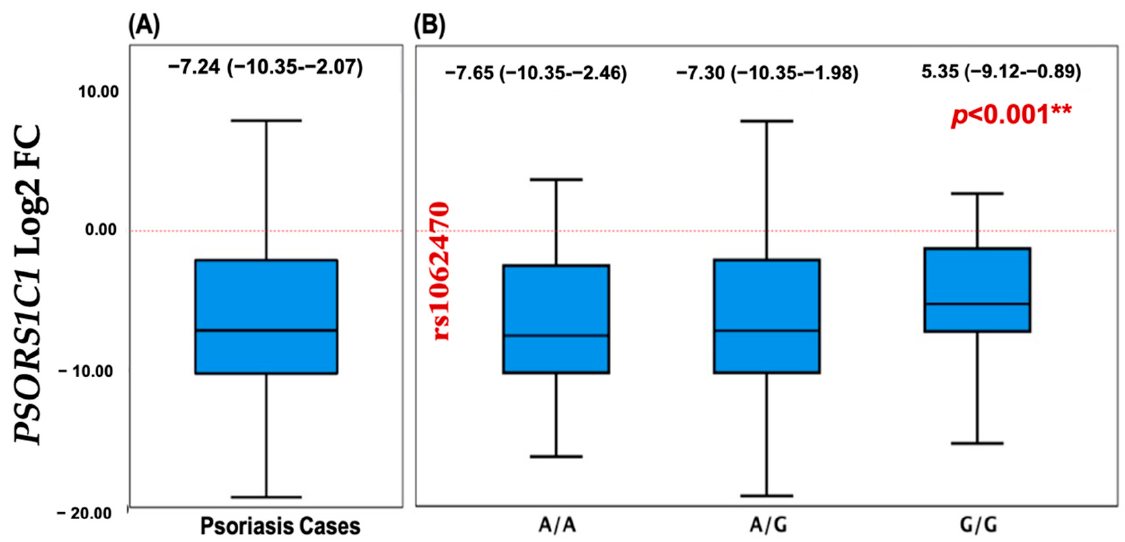
Figure 4. The relative expression profile of the PSORS1C1 gene in psoriasis plasma samples. Data are shown as medians and quartiles. Box plot values were log-transformed, as data was non-parametric. The red dotted line represents the control level. Mann–Whitney U and Kruskal–Wallis tests were applied. ( A ) Overall psoriatic samples. ( B ) Stratified by rs1062470 genotype. ** Indicate highly significant